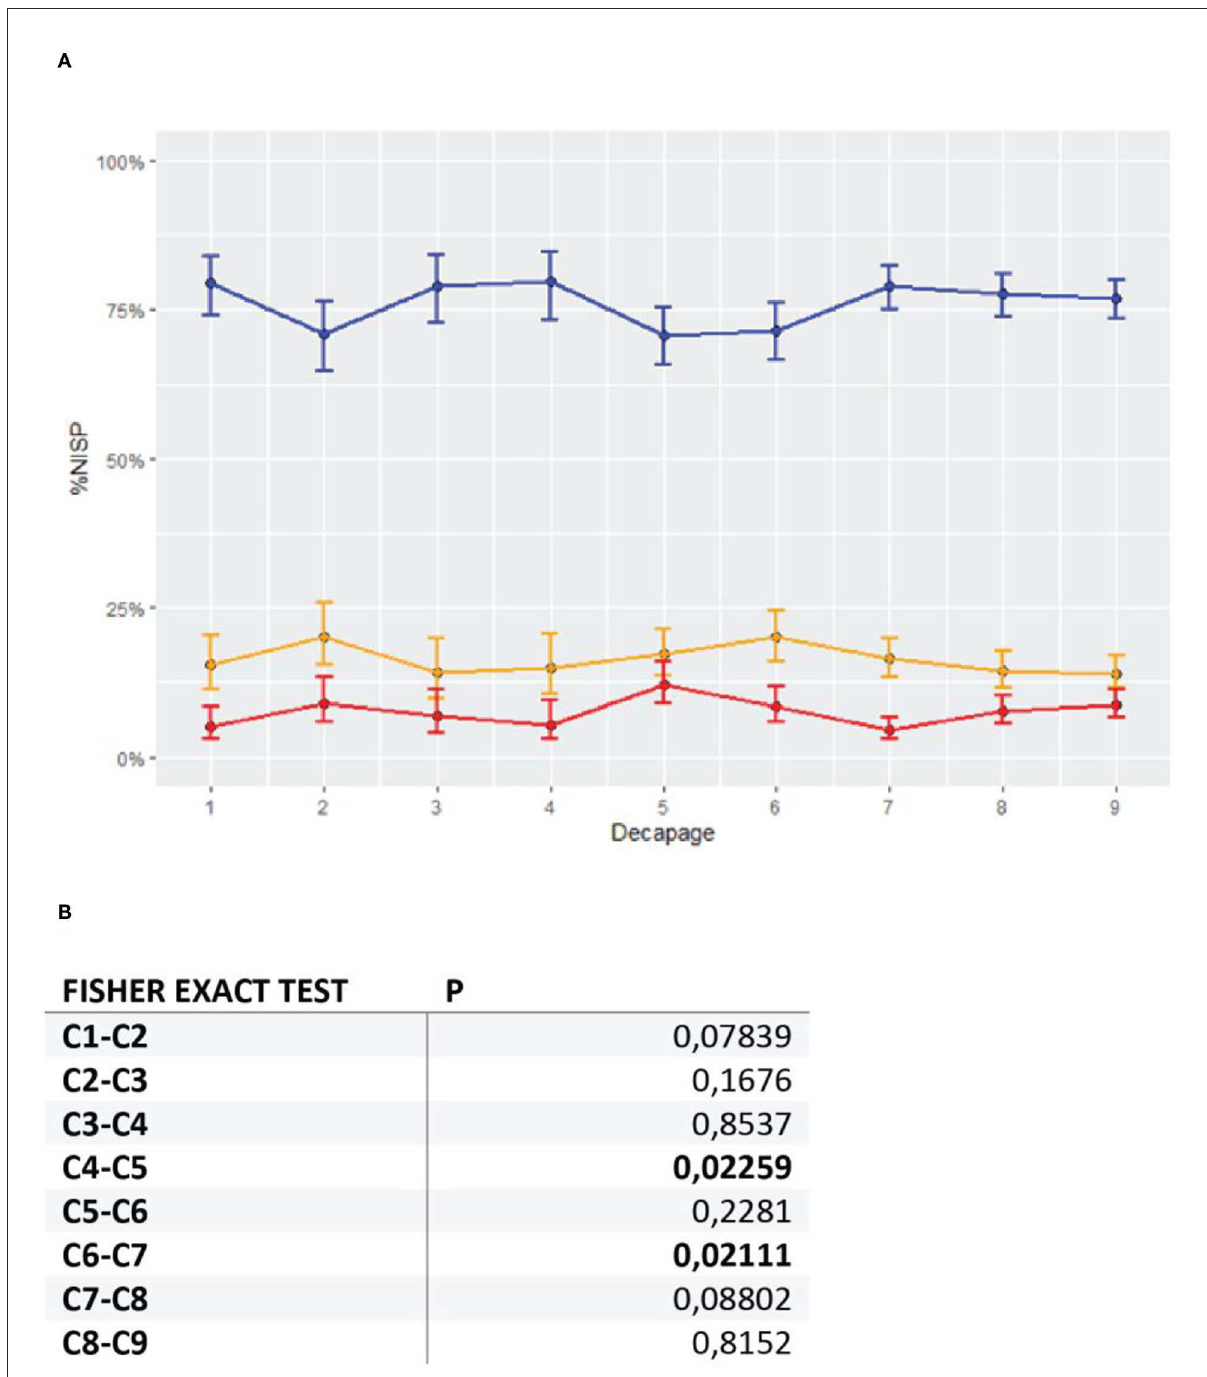
FIGURE3 (A) Variations in Reindeer (blue), Bovine (red), and Horse (yellow) %NISP per decapage, with 95% confidence intervals; (B) Paired Fisher exact tests by decapage, performed on NISP of reindeer, large bovids, and horses. Statistically significant differences in values are highlighted in bold.